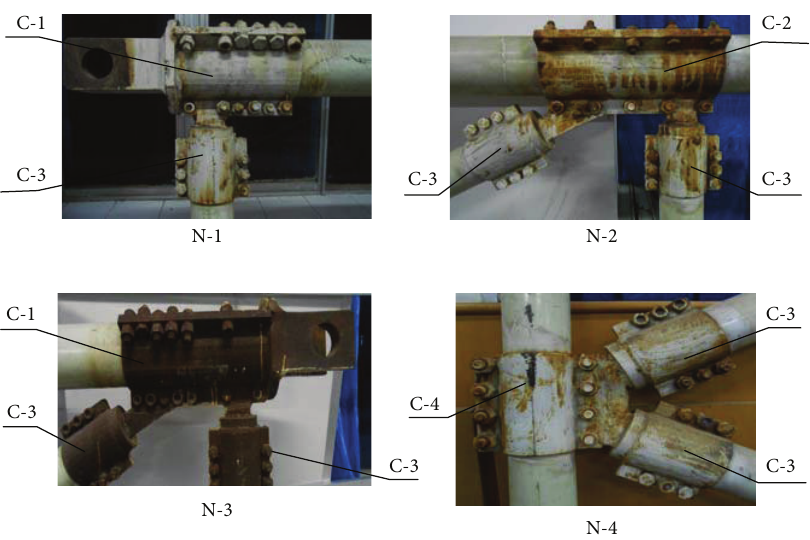
Figure 6: Classification of the joints in the GFRP-steel combined